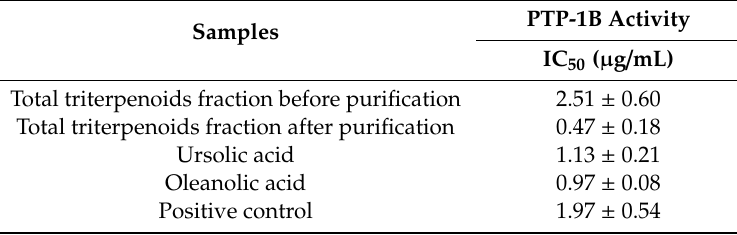
Table 3. Results of protein-tyrosine phosphatase (PTP-1B) inhibition of the total triterpenoids fractions and isolated two individual triterpenoids of D. heterophyllum